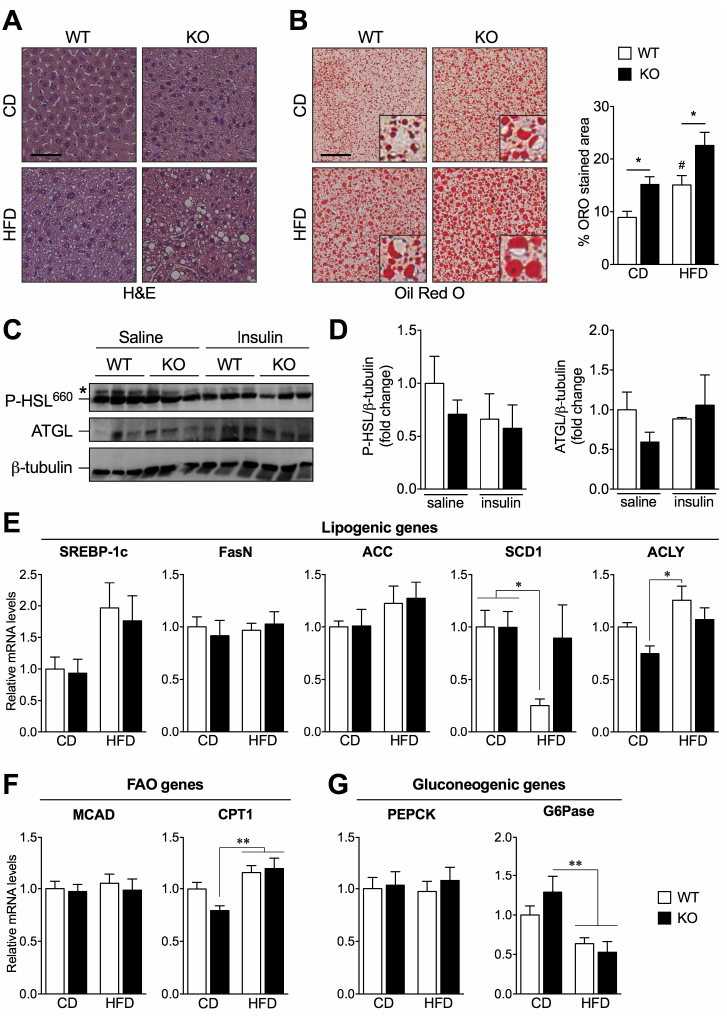
Figure 3. Loss of SIRT2 promotes hepatic steatosis and alters the expression of key genes involved in de novo lipogenesis, fatty acid oxidation, and gluconeogenesis. ( A ) Representative images of H&E-stained and ( B ) ORO-stained liver sections of WT and SIRT2-KO mice fed a CD or a HFD, n = 5 per group. ORO stained area (%) was quantified using ImageJ software (scale bar = 50 μ m). ( C ) Representative Western blots of adipose tissue lysates (50 μ g) showing P-HSL and ATGL expression levels of WT and SIRT2-KO mice fed a HFD, upon saline or insulin stimulation (i.p. injection 2 U/kg). ( D ) Levels of P-HSL and ATGL were normalized to β -tubulin in the same lane. All P-HSL/ β -tubulin and ATGL/ β -tubulin ratios were normalized to the value from WT mice injected with saline. Each lane corresponds to a distinct animal. n = 3 per group. ( E – G ) RT-qPCR analysis of lipogenic (SREBP-1c, FasN, ACC, SCD1, and ACLY), fatty acid oxidation (MCAD, CPT1), and gluconeogenic (PEPCK and G6Pase) genes in livers of WT and SIRT2-KO mice fed a CD or a HFD. Results were normalized to reference gene Ywhaz and represented as mean ± SEM; n = 5–6 per group; # p < 0.05 compared with CD-fed WT mice; * p < 0.05, ** p < 0.01.